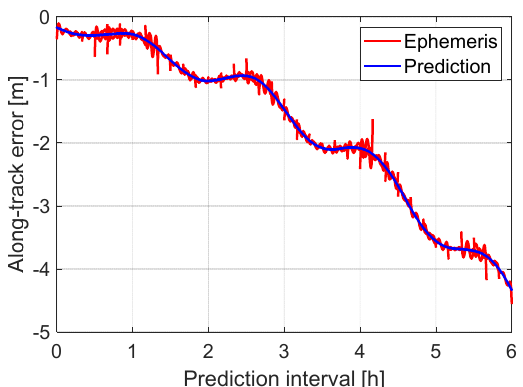
Figure 10. The along-track errors of the predicted and the ephemeris orbits from 23:00 on 15 August 2018, to 5:00 on 16 August 2018.